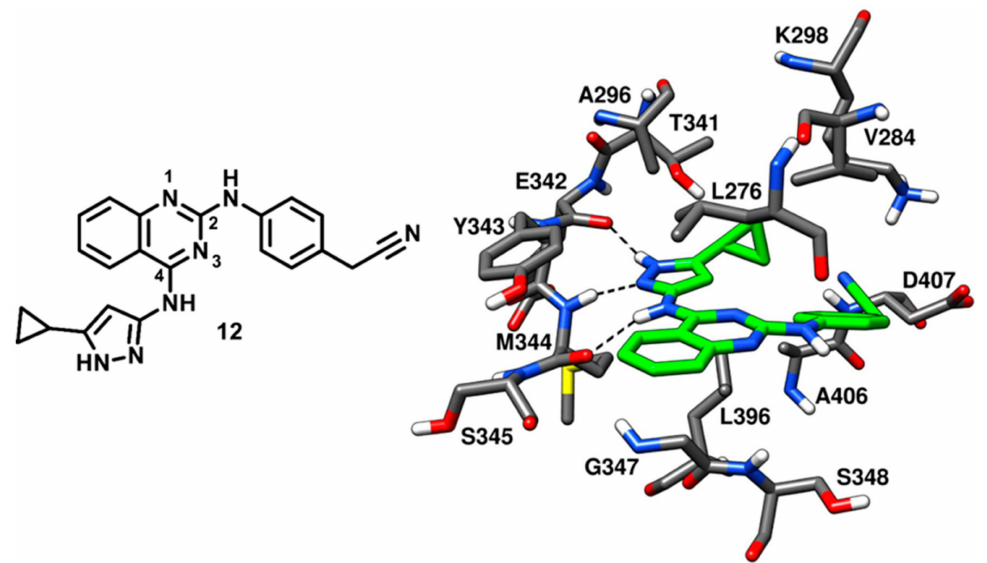
Figure 13. 2D structure of 12 and X-ray structure of c-Src kinase in complex with 12 (PDB ID: 3F6X). Active site residues of c-Src kinase and the enzyme–inhibitor H-bond interactions are